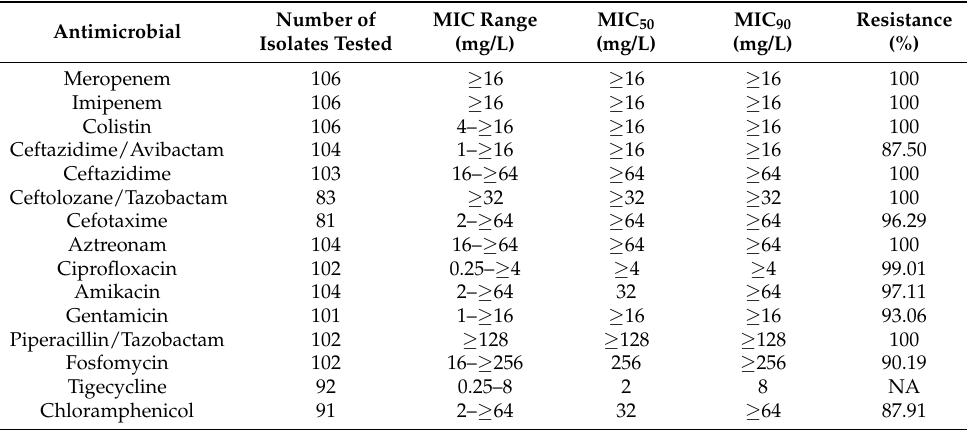
Table 2. Antimicrobial profile of K. pneumoniae isolates. NA: not